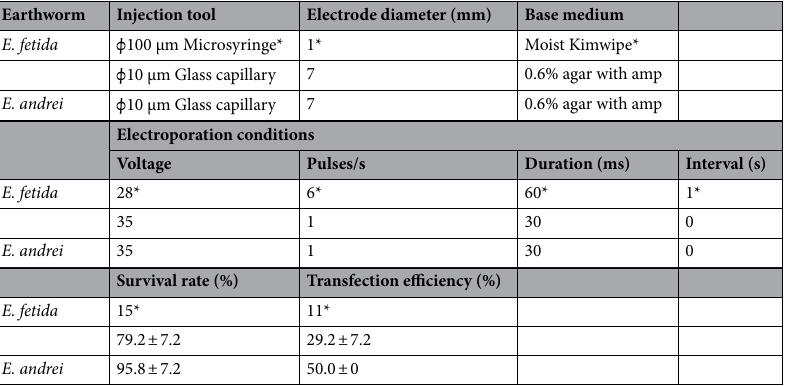
Table 1. Optimal transfection conditions for E. fetida and E. andrei . *Initial conditions. Amp, ampicillin. All experiments were performed using three groups of eight randomly selected mature earthworms for each experimental condition, except for initial conditions (average score of 20